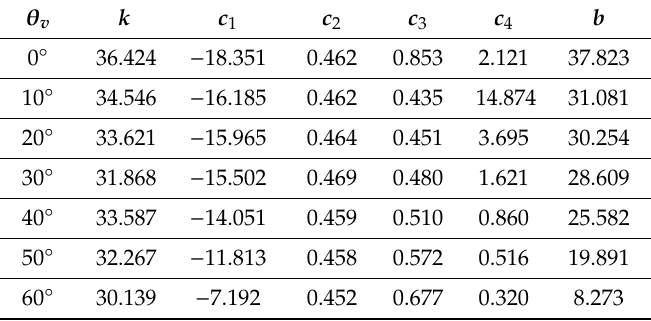
Table 4. Coe ffi cients of TOA-NLIN model at VZA 0 ◦ –60 ◦